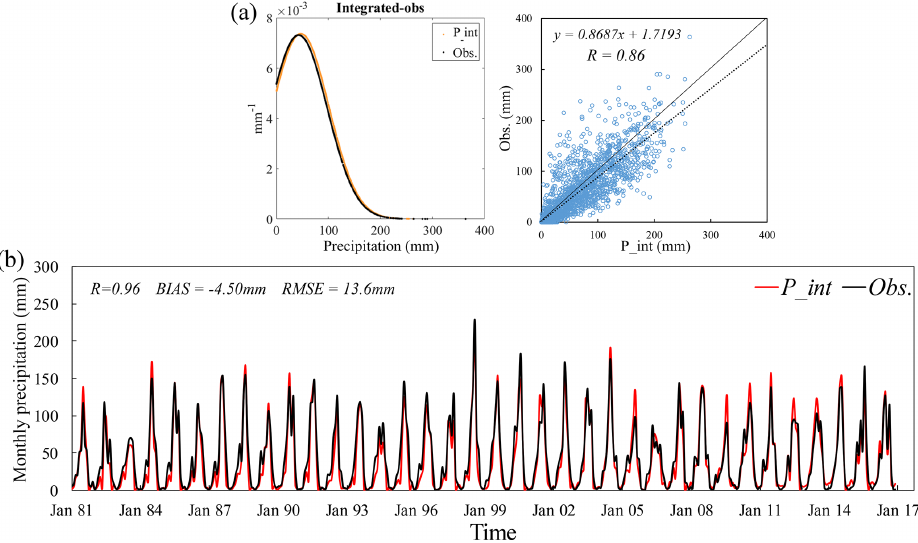
Figure 10. A validation of P _int against a long time series: (a) PDF and scatterplots for monthly precipitation at nine CMA stations, (b) station-averaged monthly precipitation from 1981 to